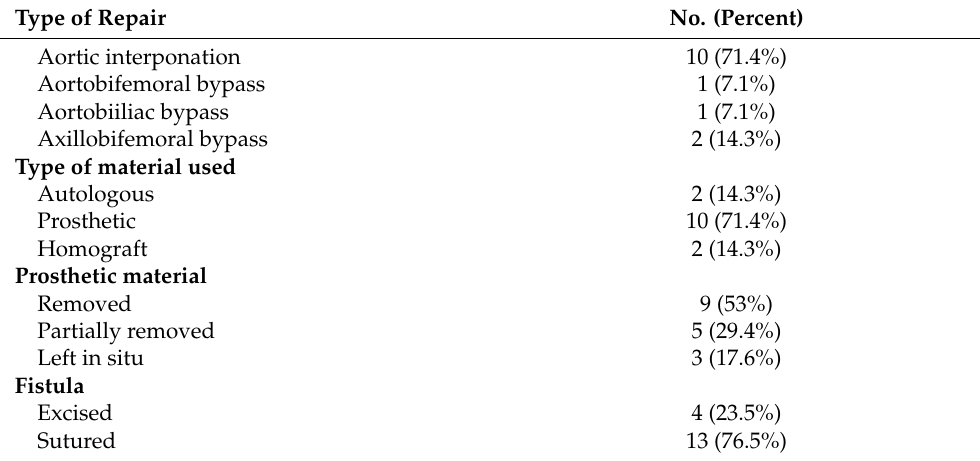
Table 2. Open surgical repair of patients with secondary aortoenteric